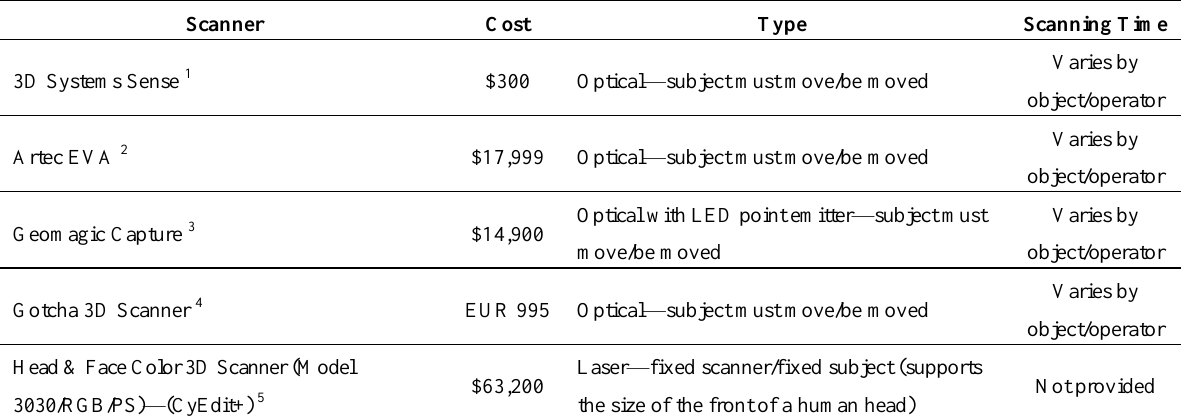
Table 1. Scanner costs and